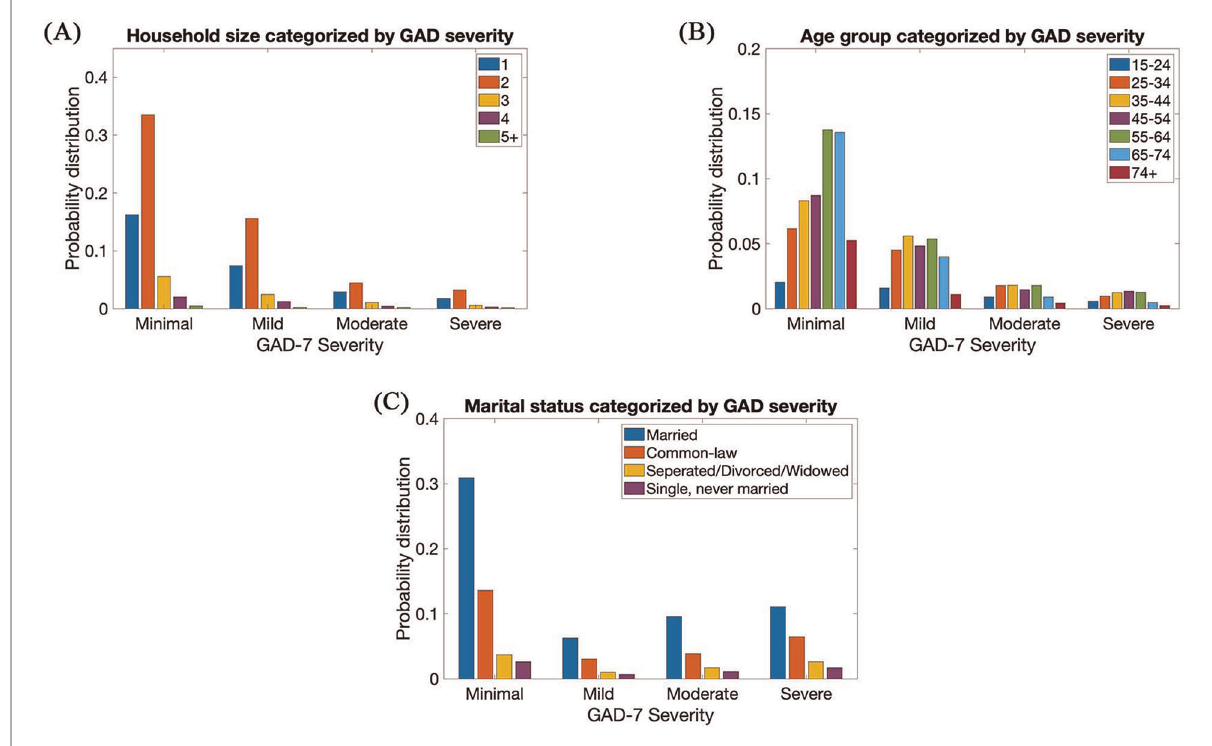
FIGURE 1 ( A ) Household, ( B ) age group, and ( C ) statistics of subjects in